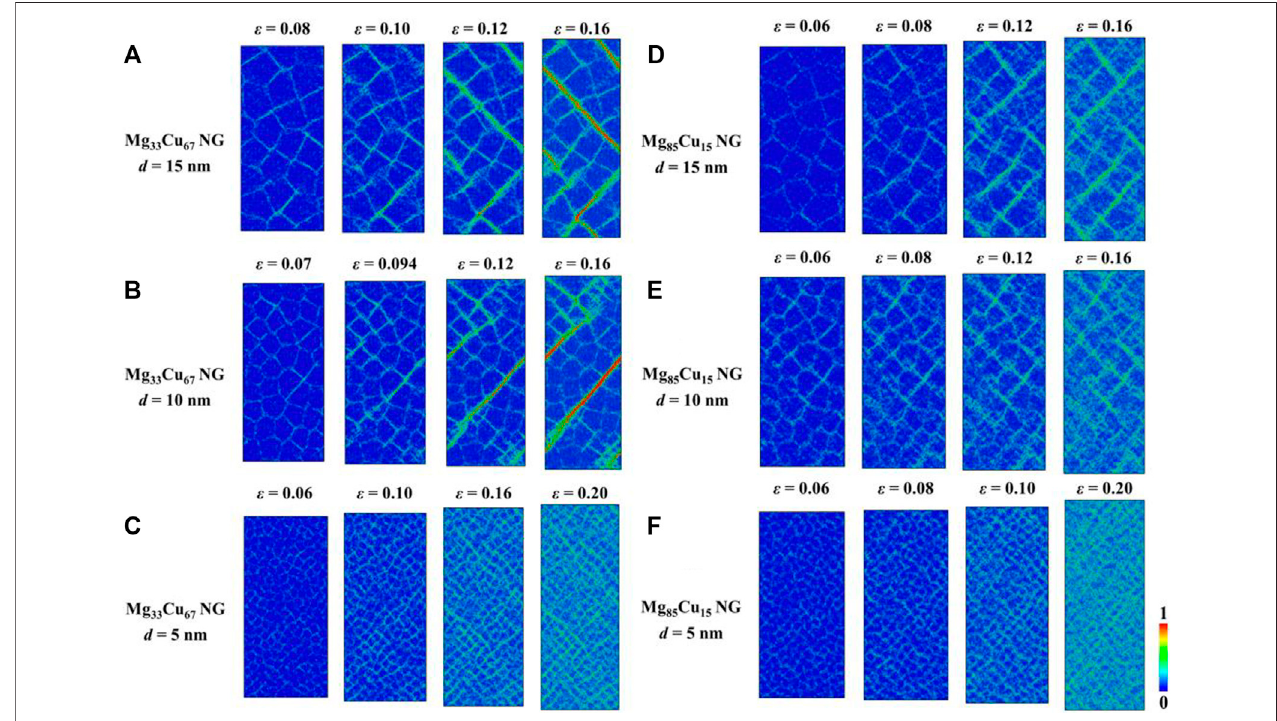
FIGURE 3 | Sequence of snapshots capturing the atomic deformation processes for (A – C) Mg 33 Cu 67 NGs with d = 15, 10, and 5 nm, respectively, and (D – F) Mg 85 Cu 15 NGs with d = 15, 10, and 5 nm, respectively. The colors indicate the atomic shear